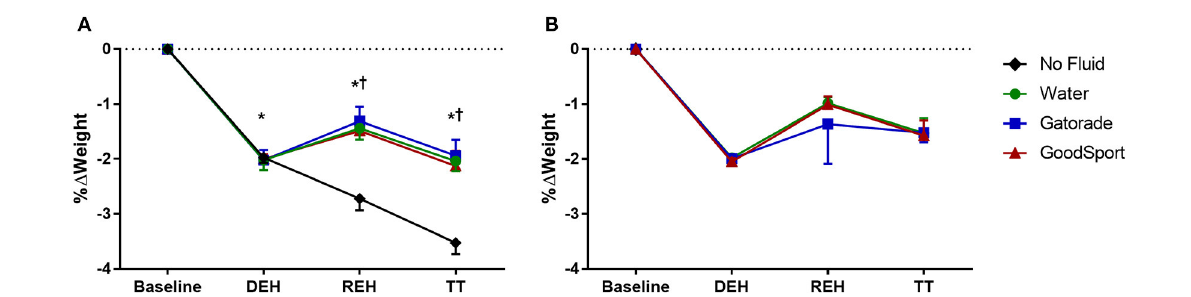
TABLE 4 | Cumulative urine output and change in plasma volume.